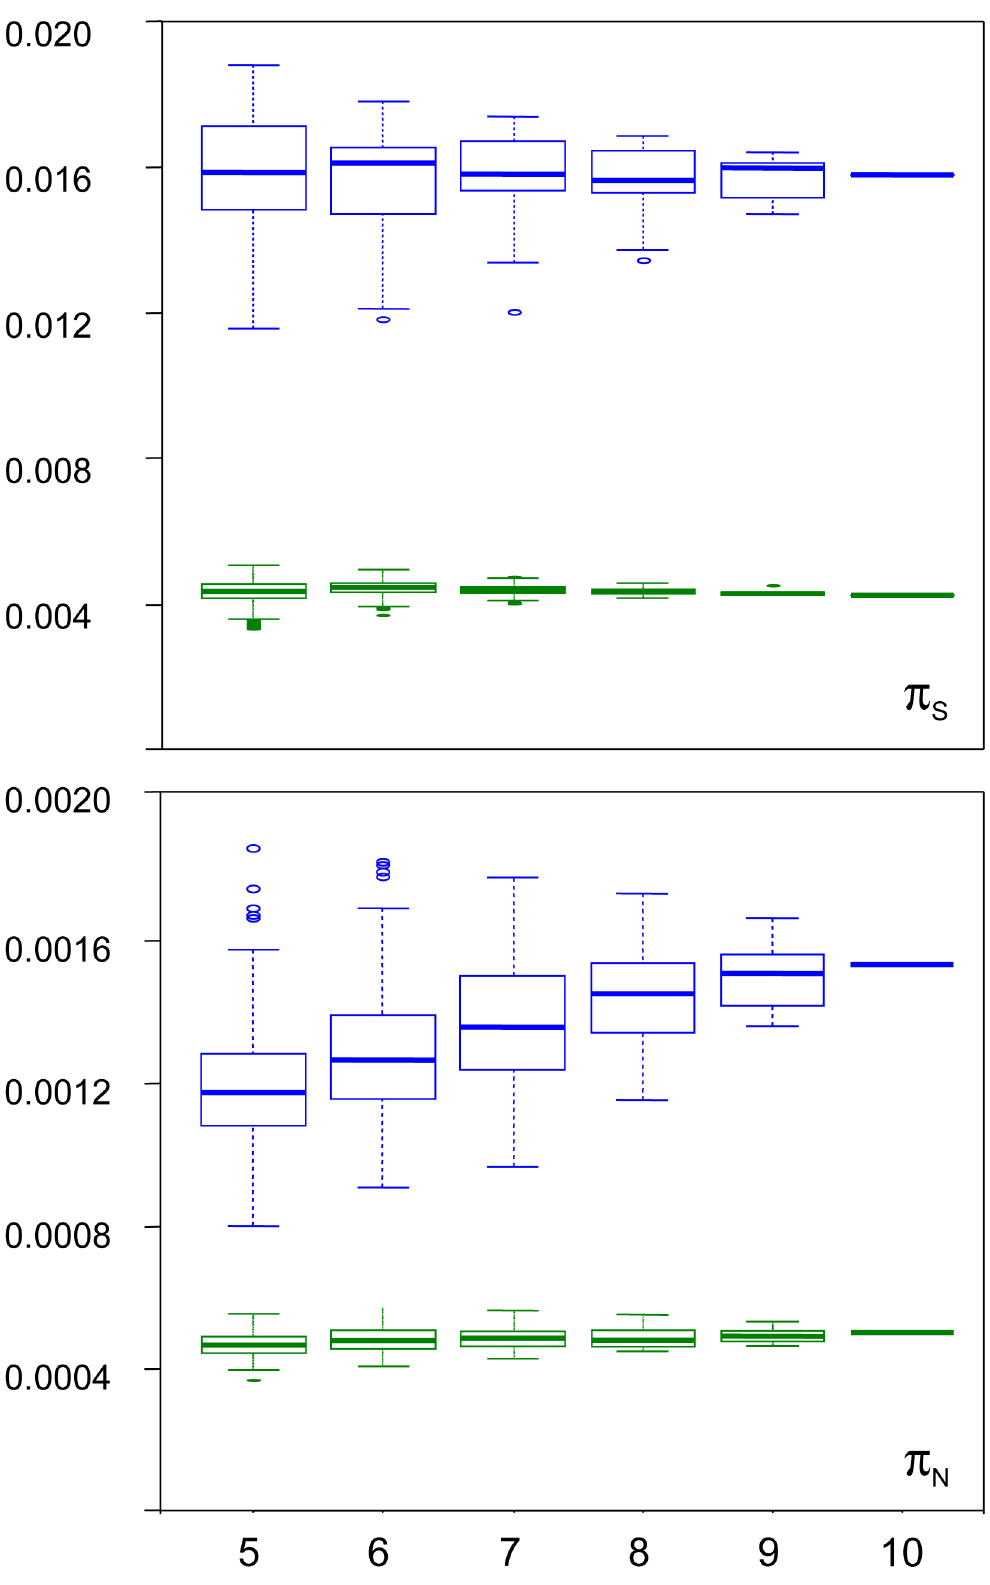
Figure 3. Sampling variance of p N and p S in the turtle Emysorbicularis and the tunicate Cionaintestinalis A. X-axis: size of individual sub- samples; Y-axis: box-plot of estimated synonymous (top) and non-synonymous (bottom) diversity in turtle (green) and ciona (blue).